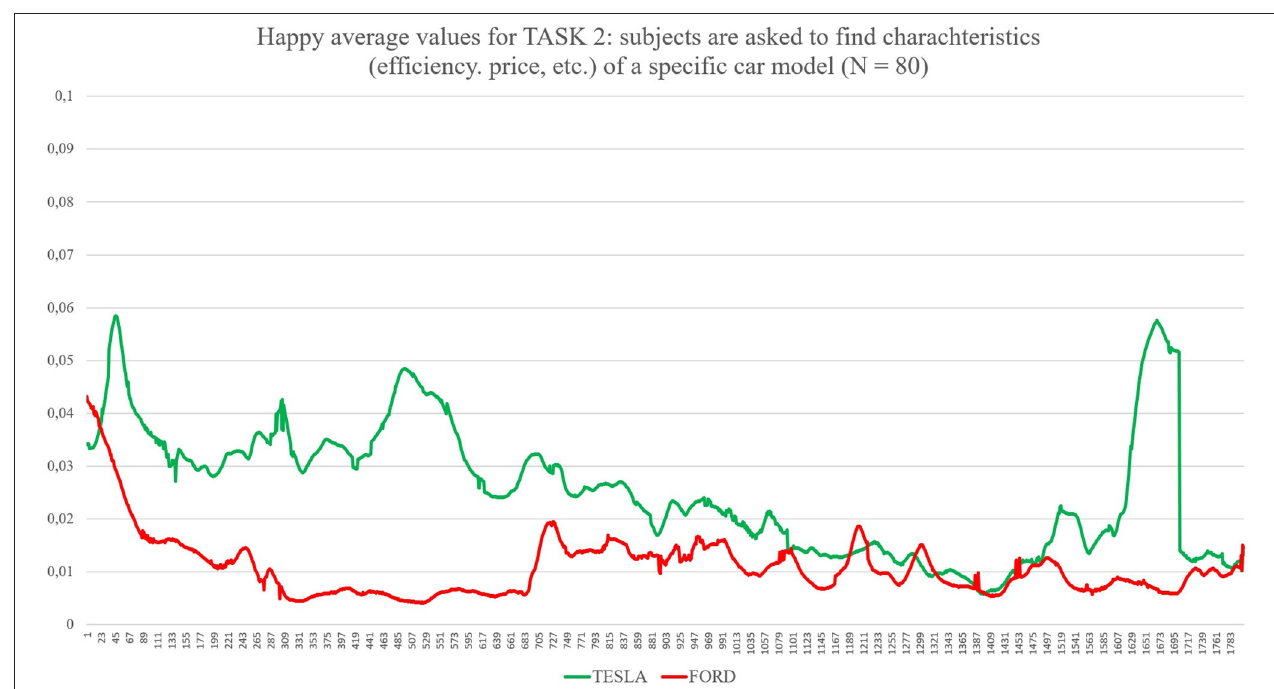
FIGURE 2 | The graph shows values for Happiness for both Tesla and Ford during Task 2 (subjects were asked to look for characteristics of a specific car model). On the X axis, time is expressed in 30 samples per second for a total of 1,800 samples, corresponding to 60s as the total maximum amount of time exposure to the website during this task. On the Y axes, values of happiness are expressed between 0 (no happiness expressed by the face) and 1 (highest intensity of happiness expressed by the